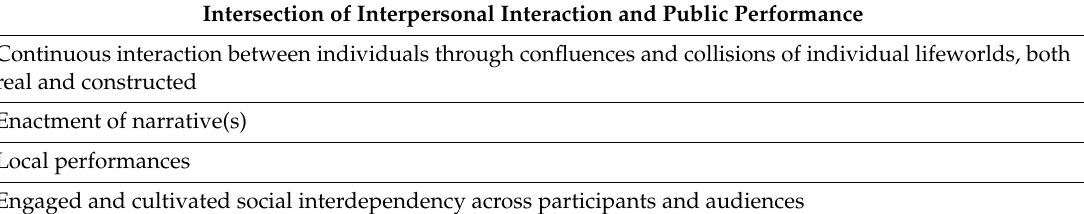
Table 2. Incarnation of New Modes of Being in a Narrative Construction. Intersection of Interpersonal Interaction and Public Performance Continuous interaction between individuals through confluences and collisions of individual lifeworlds, both real and constructed Enactment of narrative(s) Local performances Engaged and cultivated social interdependency across participants and